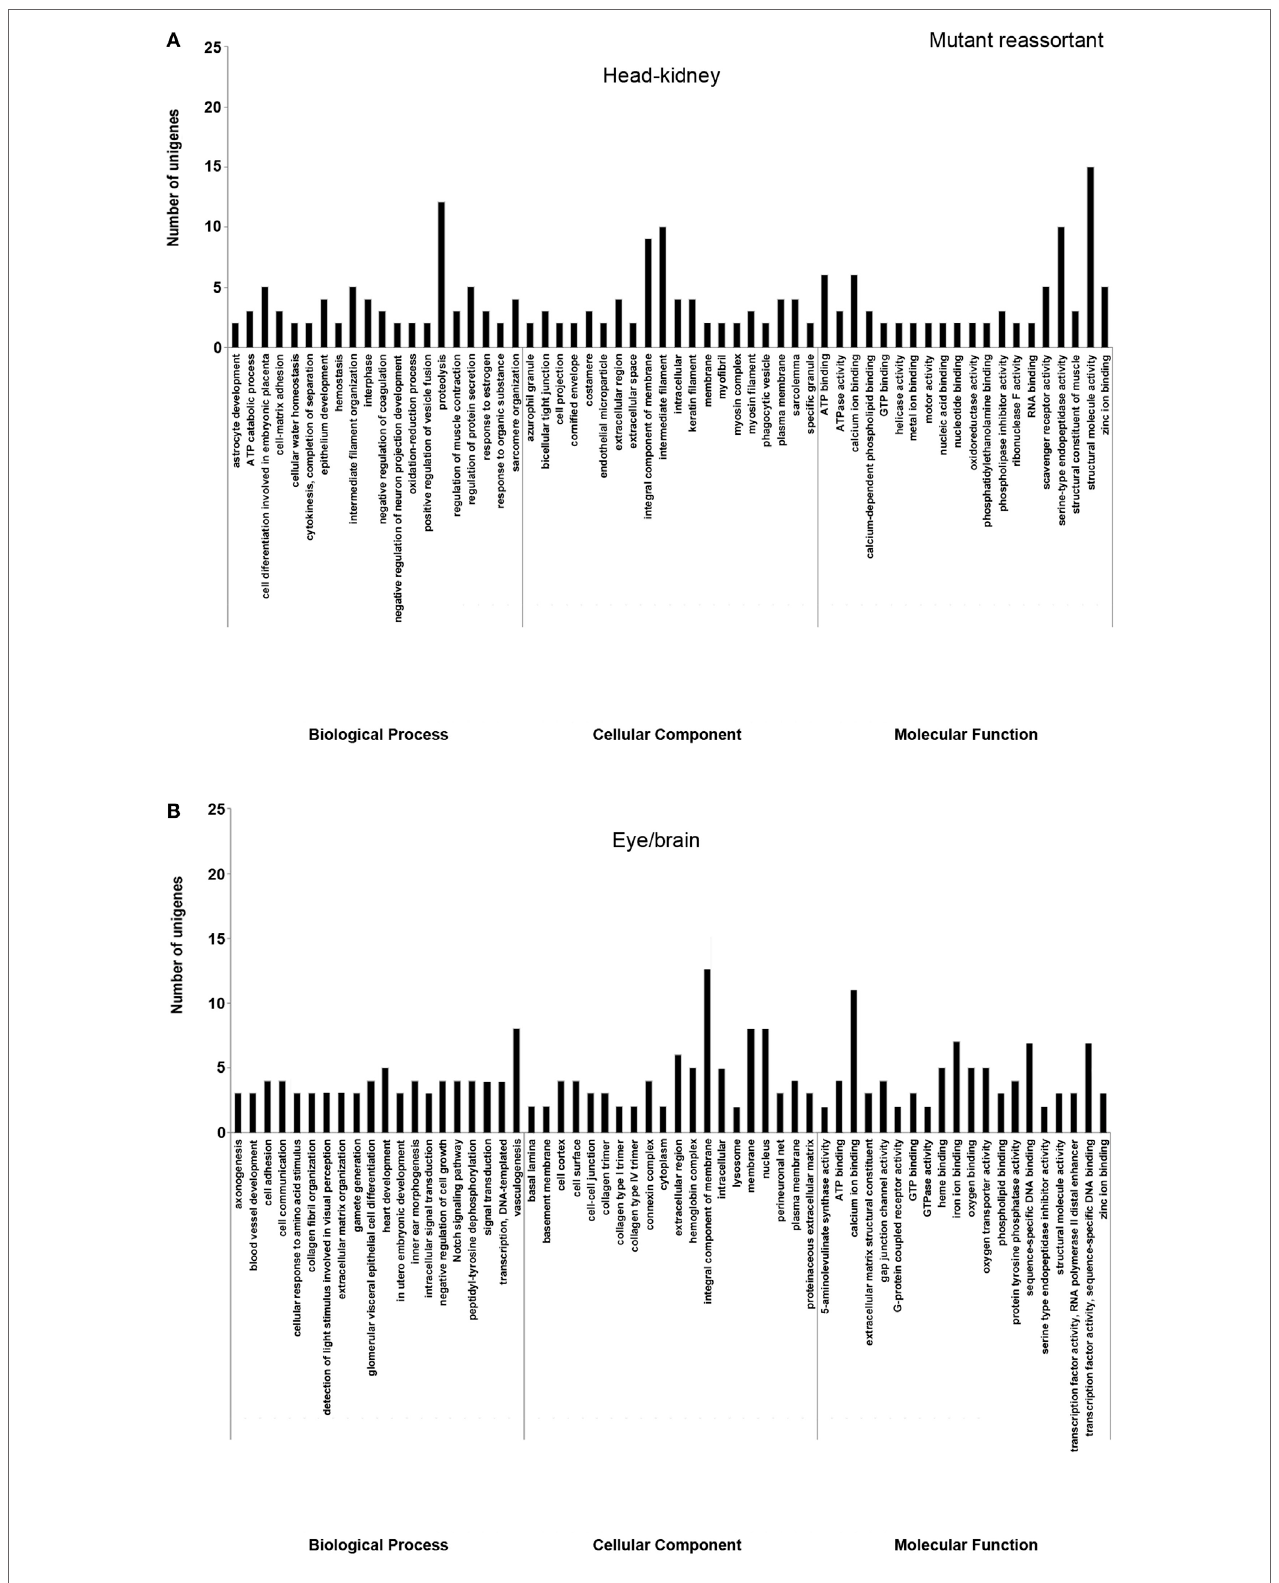
FigUre 3 | Gene ontology enrichment analysis of differentially expressed genes from head kidney (a) and eye/brain (b) samples of Senegalese sole animals infected with the mutant reassortant. Ontologies were classified into three subclasses, including biological process, cellular component, and molecular